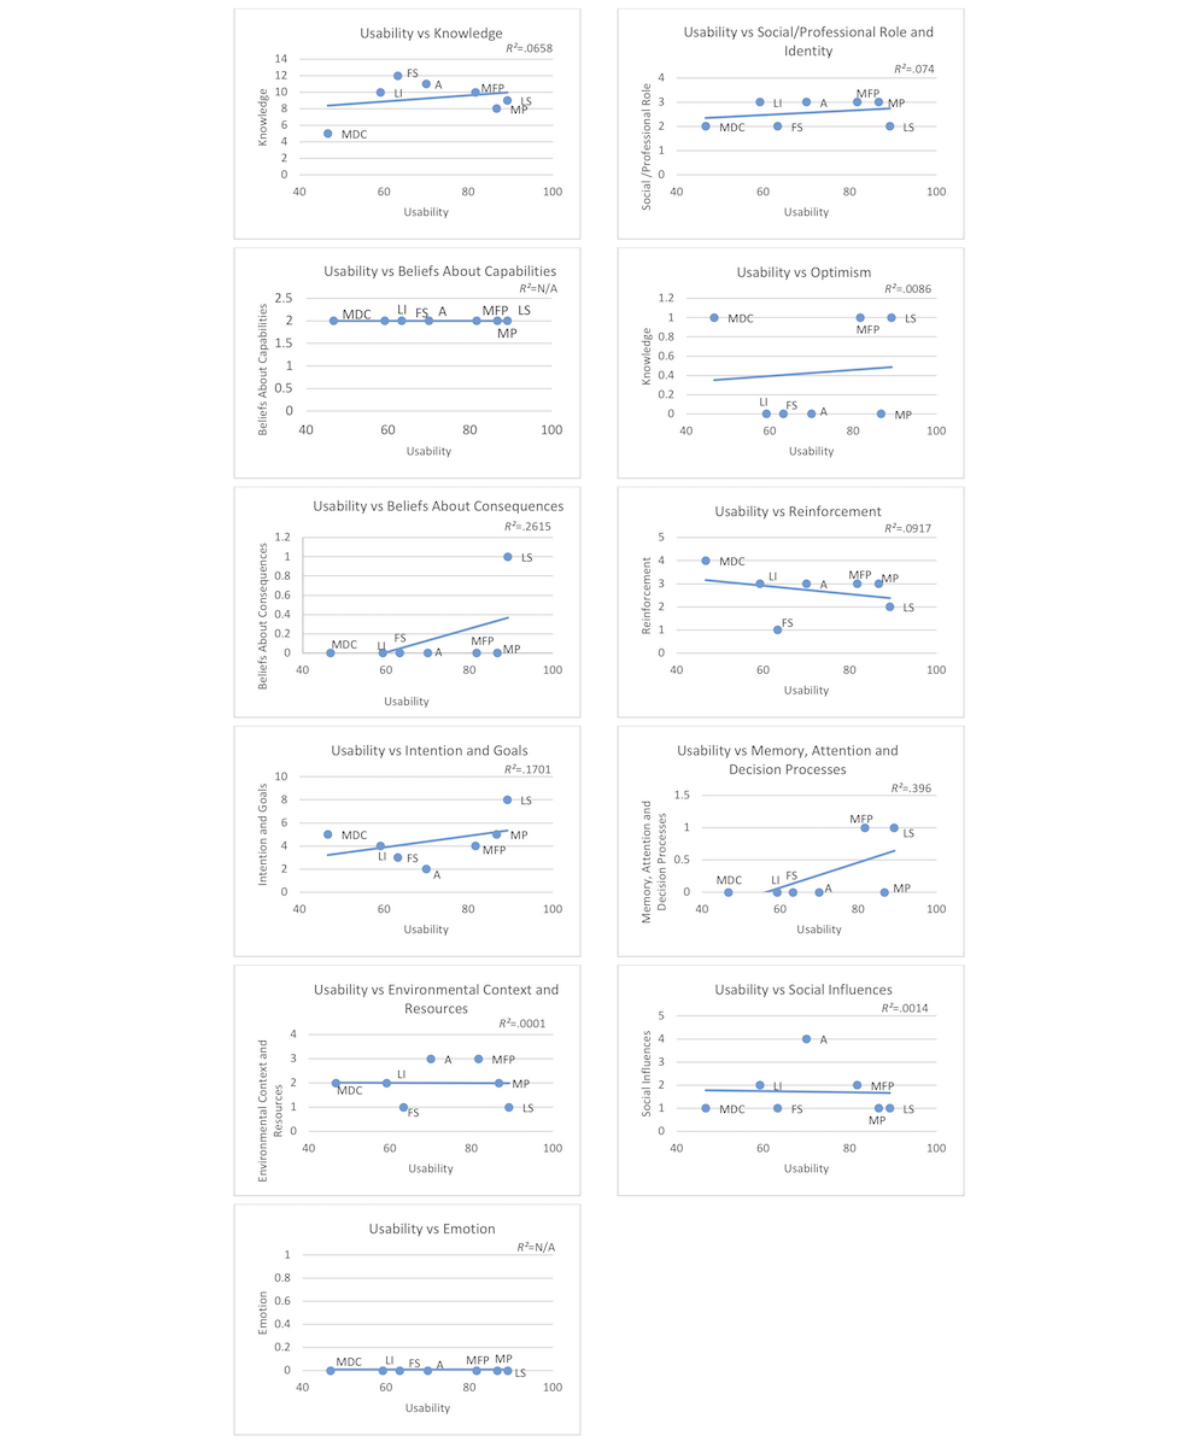
Figure 3. Individual feature correlation with usability. MDC: MyDietCoach; LI: Lose It!; FS: FatSecret; A: Argus; MFP: MyFitnessPal; MP: MyPlate; LS: